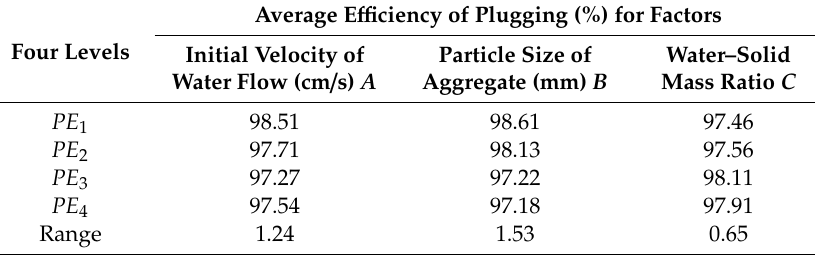
Figure 6. Response graphs of main e ff ects in accordance with Table 3. Table 3. Range analysis for main e ff ects of plugging in tunnel with flow water.